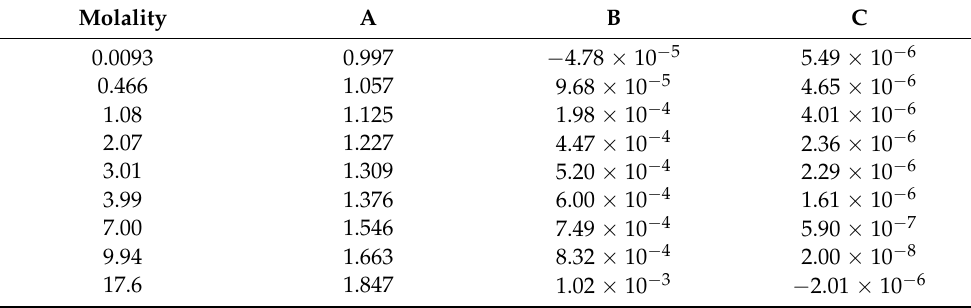
Table A28. Coefficients of the H 2 O-Ca(NO 3 ) 2 density equation.